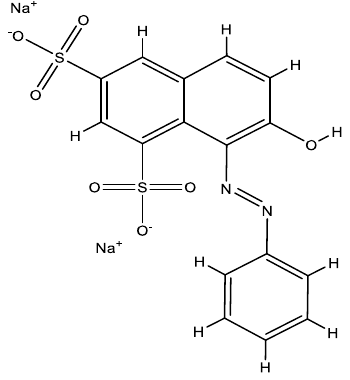
Figure 1. Molecular structure of Orange G (OG) dye.